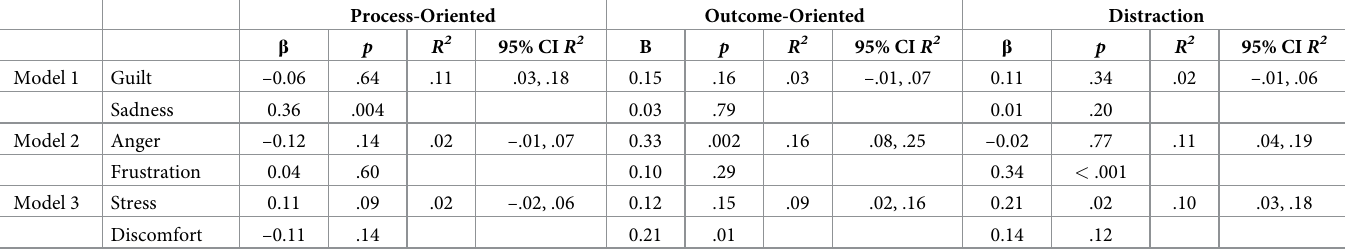
Table 6. Proportion of variance accounted for parenting behaviors by emotion groups—children’s justified emotions.